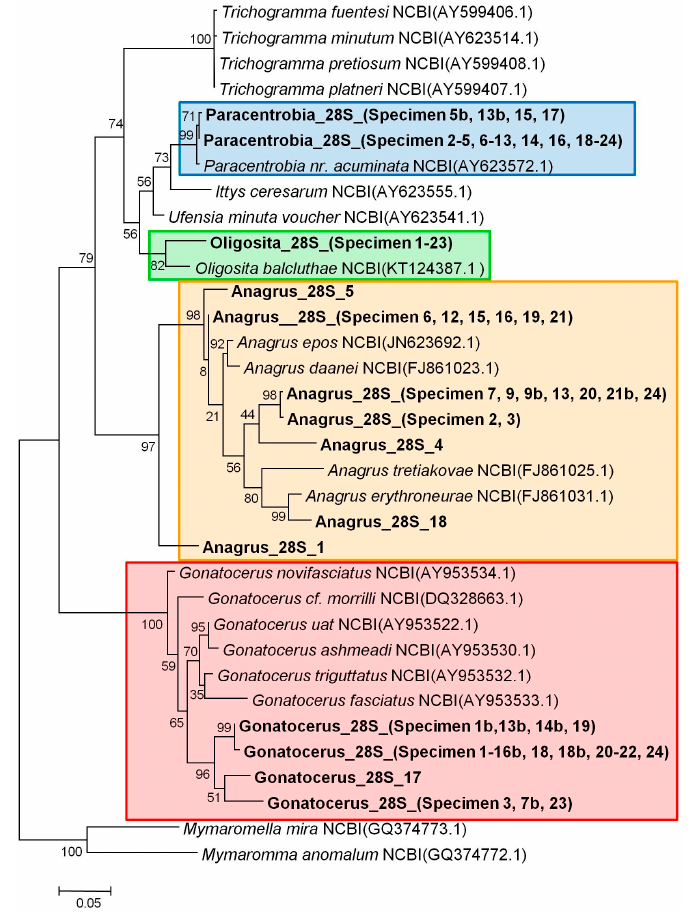
Figure 1. Maximum likelihood tree for the 28S rRNA gene sequences (bootstraps = 1000, TN93 model). Specimens with the same haplotype were pooled. A full list of the specimens used can be found in Supplementary Table S2. Maximum likelihood bootstrap values are given for each node.